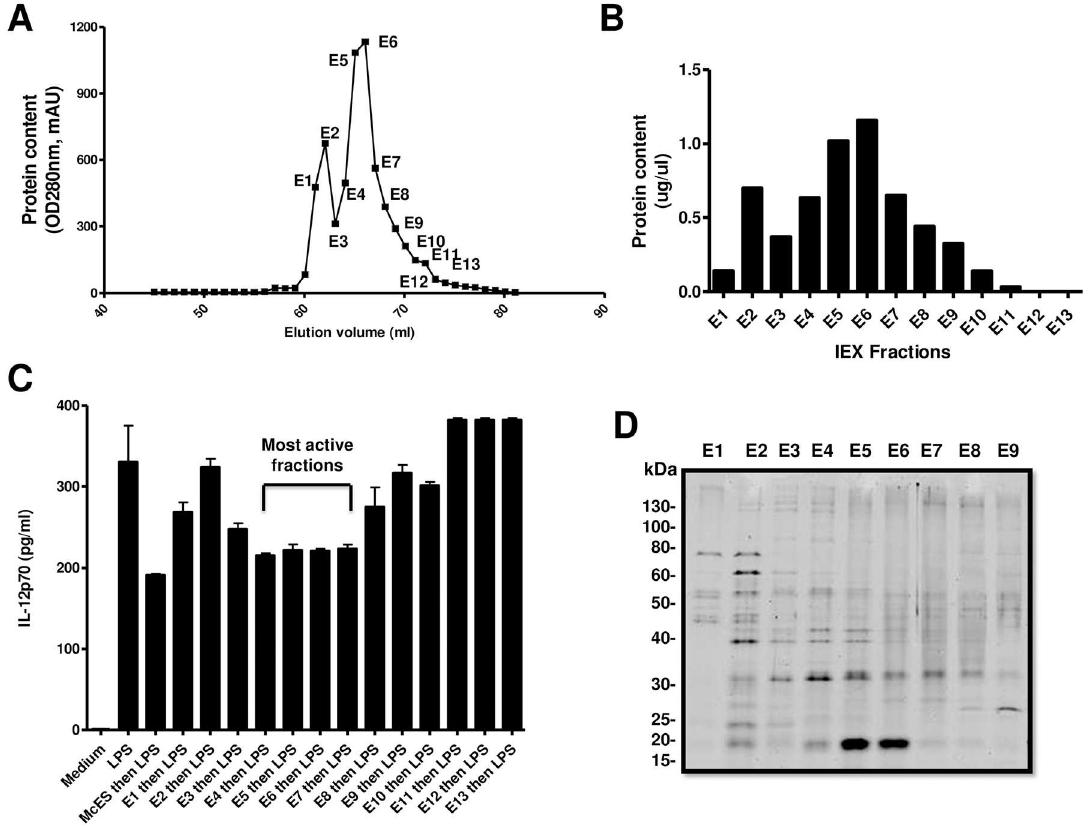
Fig 8. First line fractionation of McES by Ion Exchange Chromatography and Bio-assessment. McES dialysedagainst Tris-HCl was separated on an Ion exchangecolumn at pH 6 using a linear salt (NaCl) gradient-based elution. (A) Protein elution profile of McES at 280 nm. (B) Protein concentration of eluted fractions of McES, as measured by Bicinchoninic acid assay. (C) LPS-driven IL-12p70release followingBMDC pre-exposure to 5 μ g/ml of each McES fractions. Most active IEX fractions are indicated. (D) One-dimensional SDS-PAGE of 1 μ g of the most represented Ion-exchange-chromatography- based McES fractions.